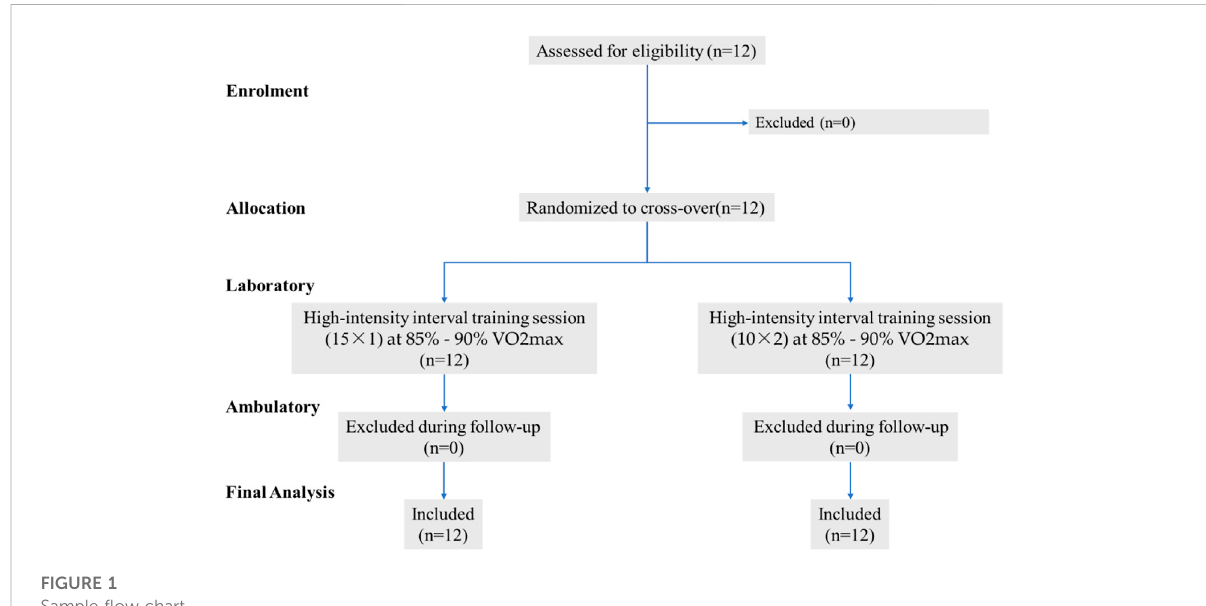
FIGURE 1 Sample fl ow